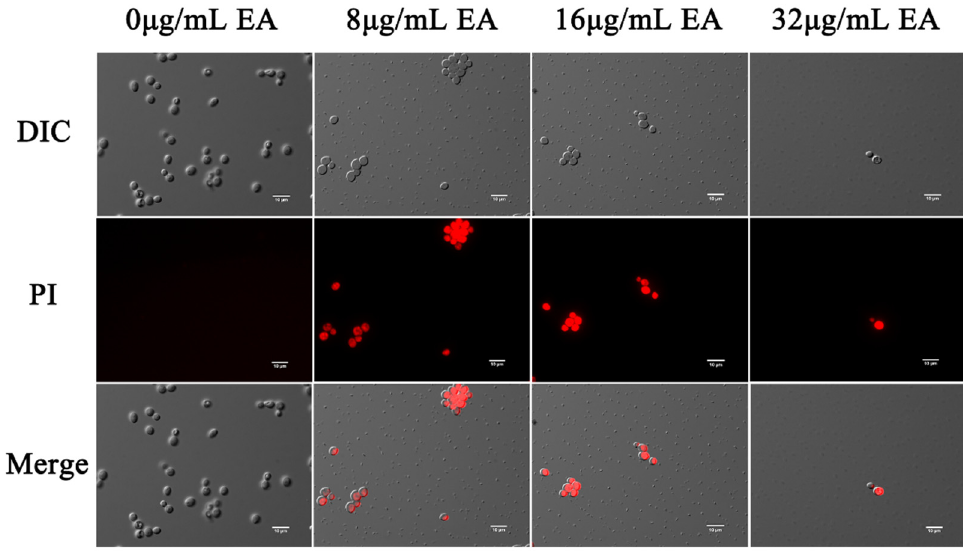
Figure 6. Effect of EA on the cell membrane permeability of C. albicans . Cells were observed under a Nikon 80I fluorescence microscope (63× oil immersion objective). Scale bars represent 10 μ m.